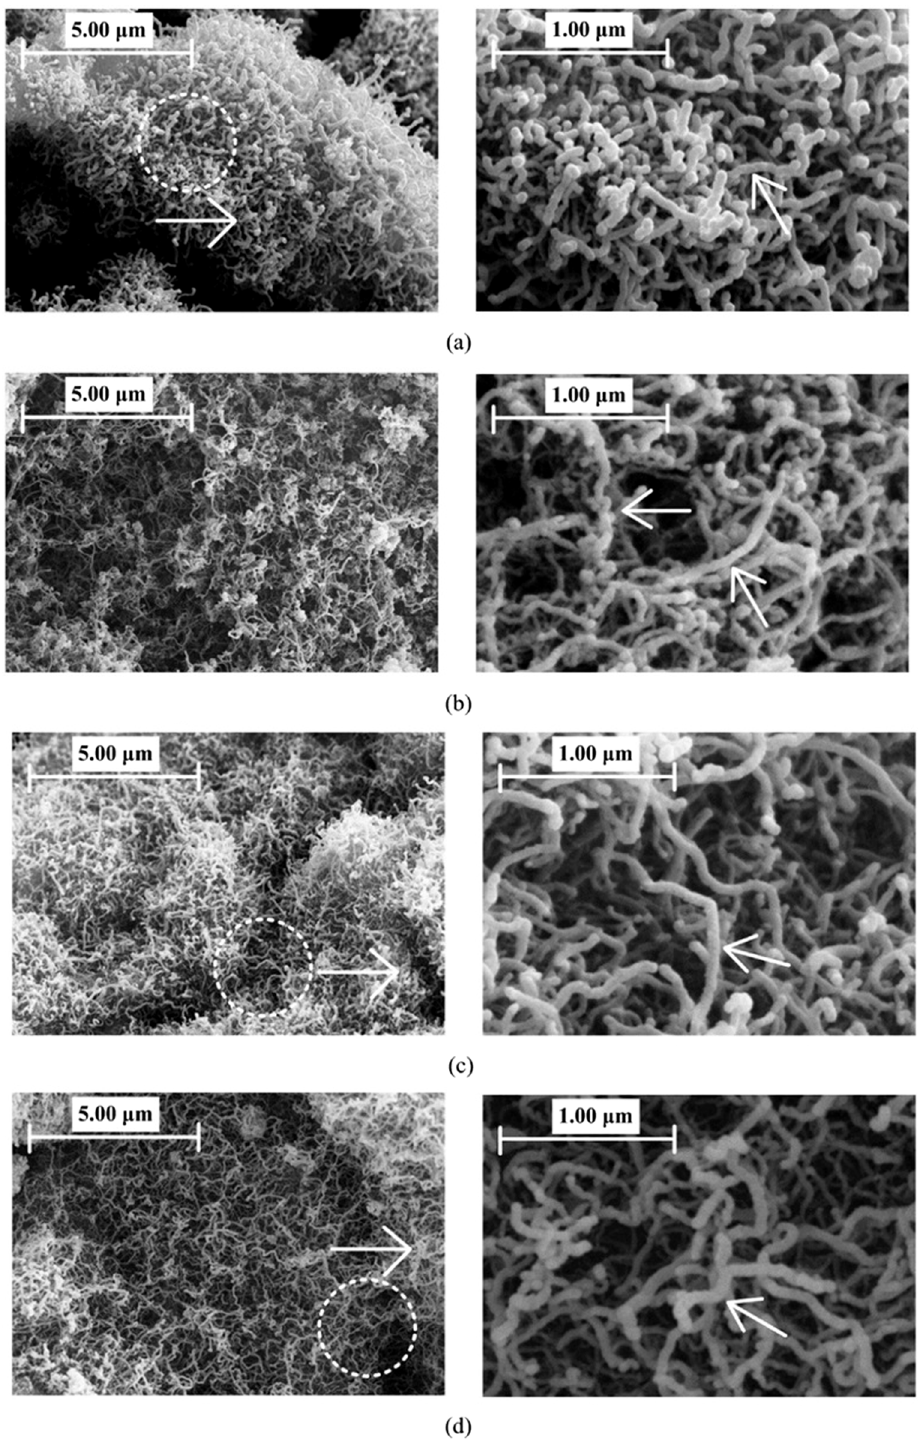
Figure 10: SEM images of carbon products from various sources. Copied with permission from ref. [ 84 ] ; Elsevier, 2018. ( a ) CNTs from CH 4 = 0.2 atm ) , ( b ) CNTs from CO decomposition process ( P = 0.2 atm ) , ( c ) CNTs from CO/CH decomposition process ( P CH CO 4 = 0.5 ) , and ( d ) CNTs from CO/CH ( P = 2 ) process ( P CO / P CH 4 decomposition process CO / P CH 4 4